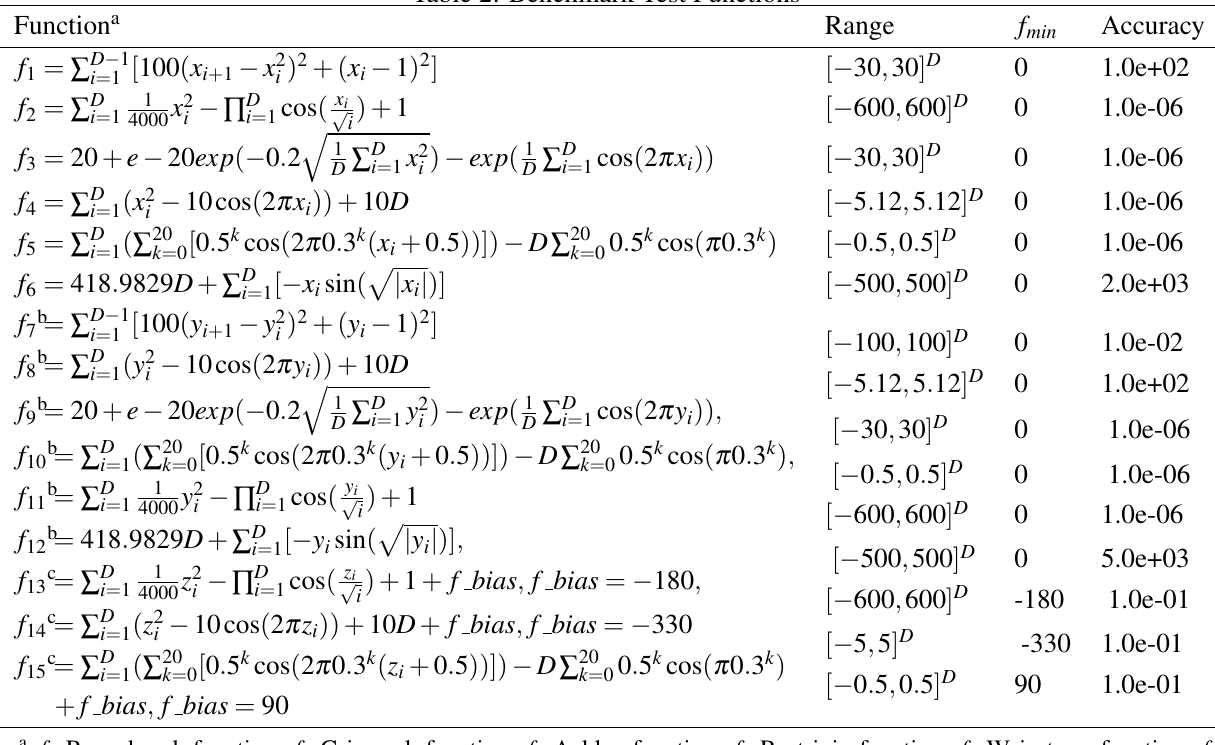
Table 2: Benchmark Test Functions